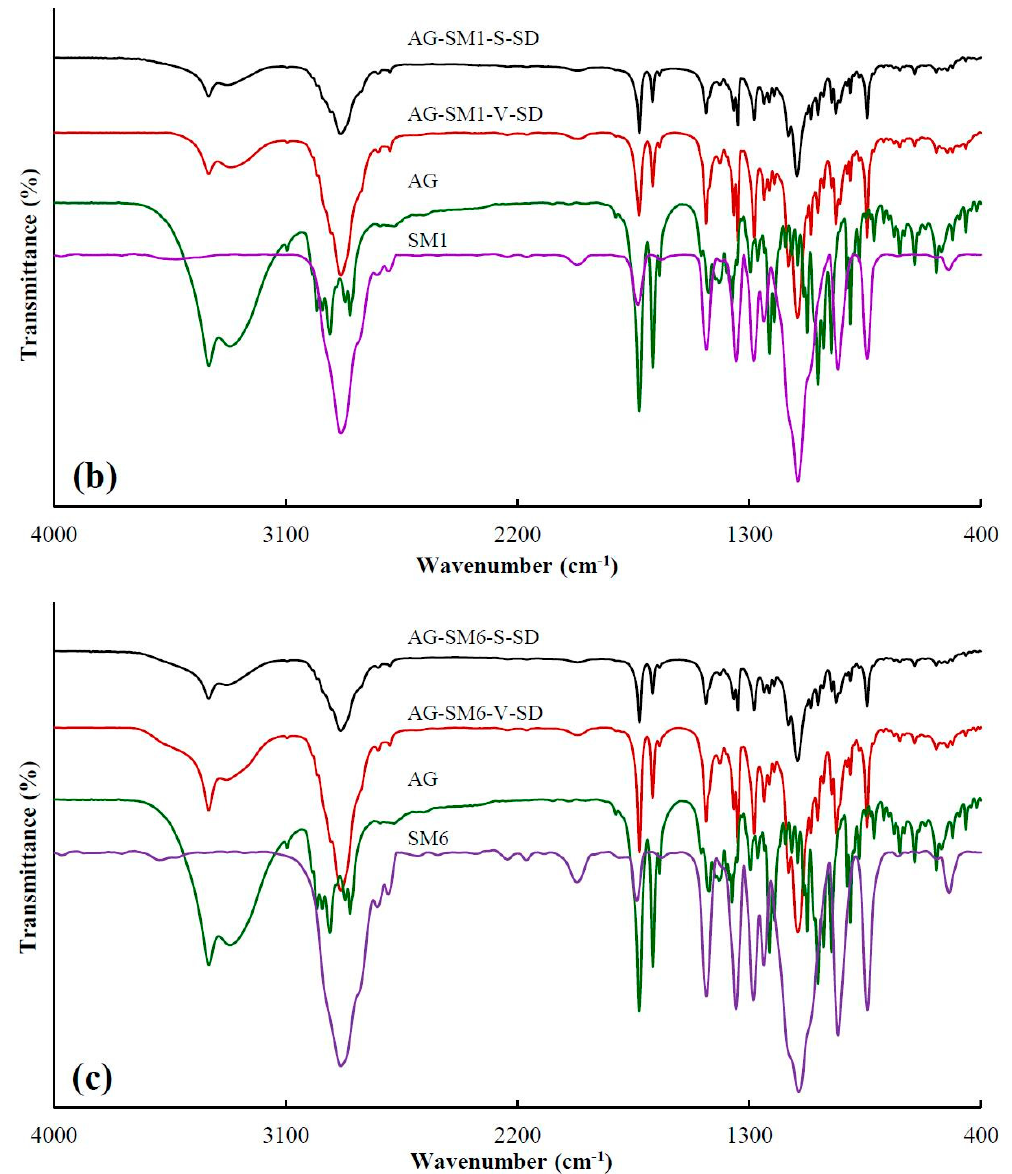
Figure 2. FT-IR spectra of pure andrographolide (AG), carrier materials, and solid dispersions (SD): ( a ) PEG4000 as carrier material, ( b ) SM1 as carrier material, ( c ) SM6 as carrier